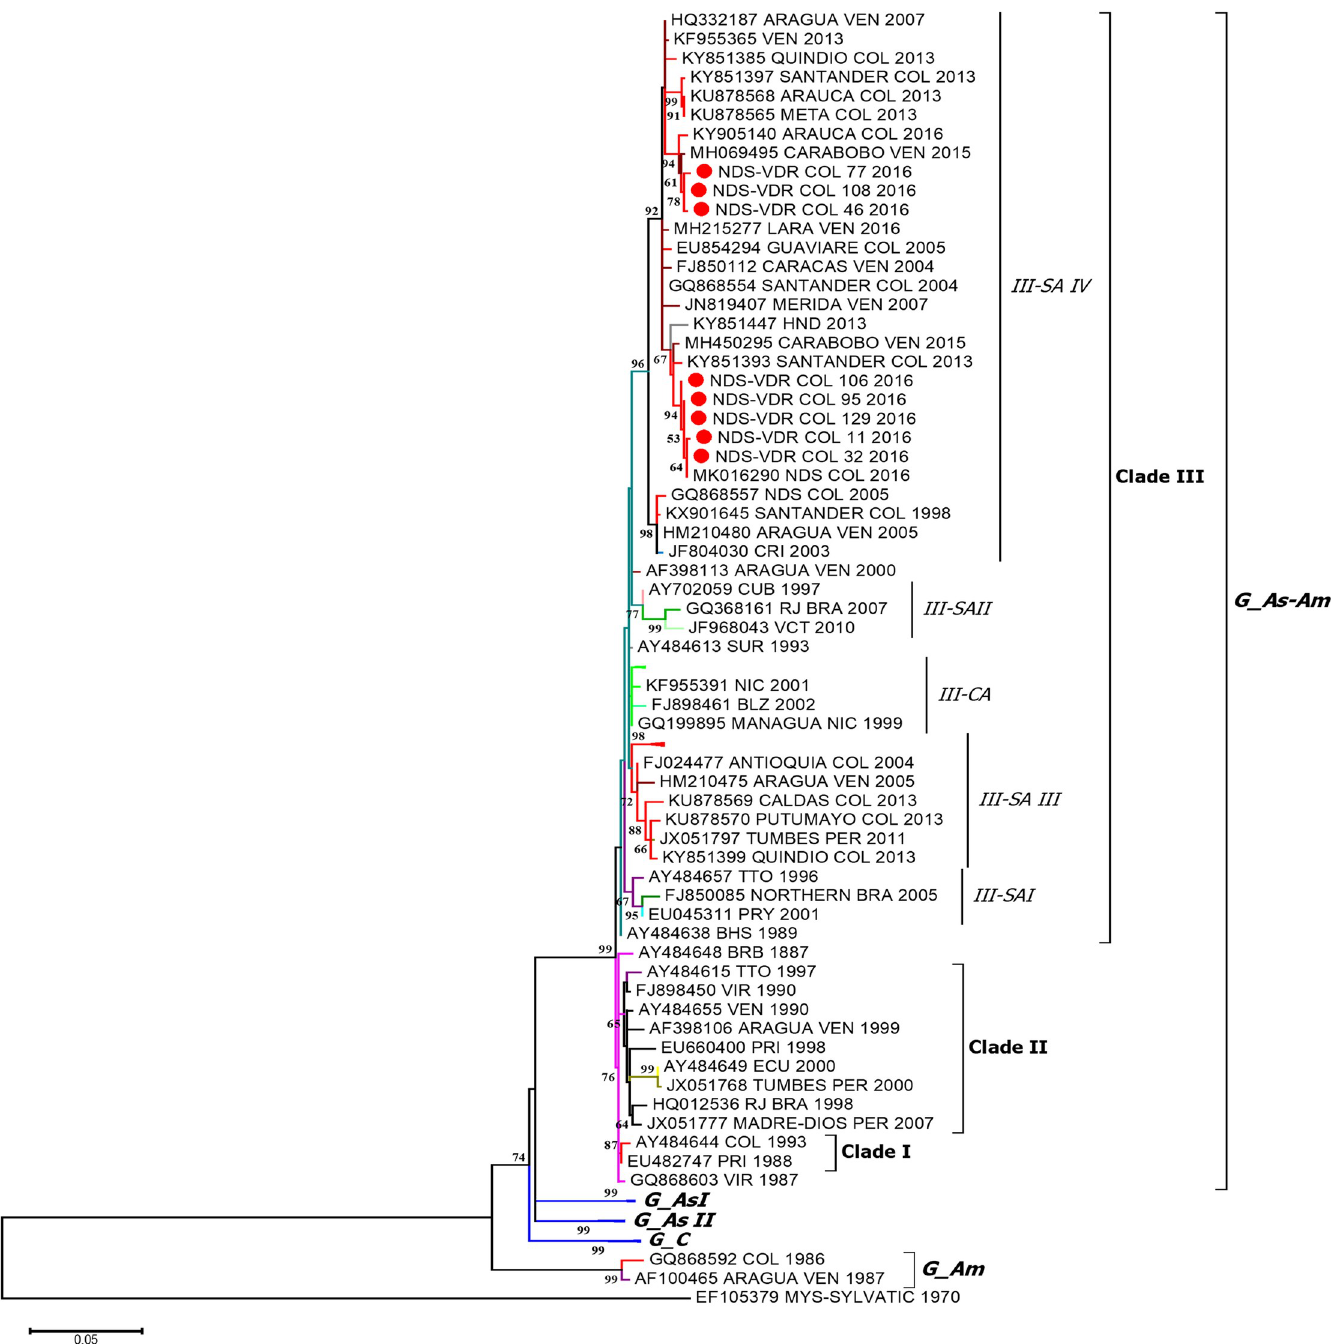
Fig 3. Phylogenetic analysis of DENV-2 strains. The analysis was performed using the maximum likelihood method based on the E gene, using 8 sequences of 1178 nt in length and 142 sequences that have been previously deposited in GenBank. The tree was reconstructed using the nucleotide replacement model TN93 + G + I. The red circles represent the sequences from Norte de Santander and identified as NDS-VDR. G: Genotype, C: Cosmopolitan, As: Asian, Am: American, SA: South America and CA: Central America. Color Code: Red: Colombia, Light Blue: Venezuela Light green: Mexico, Blue: Argentina, Green: Brazil, Orange: Ecuador, and purple: Asian